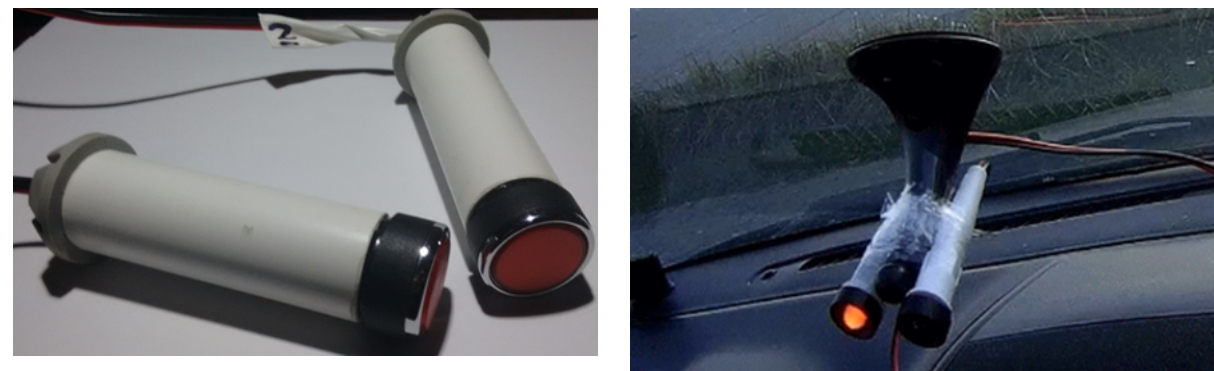
Figure 5: Red light signal [18].